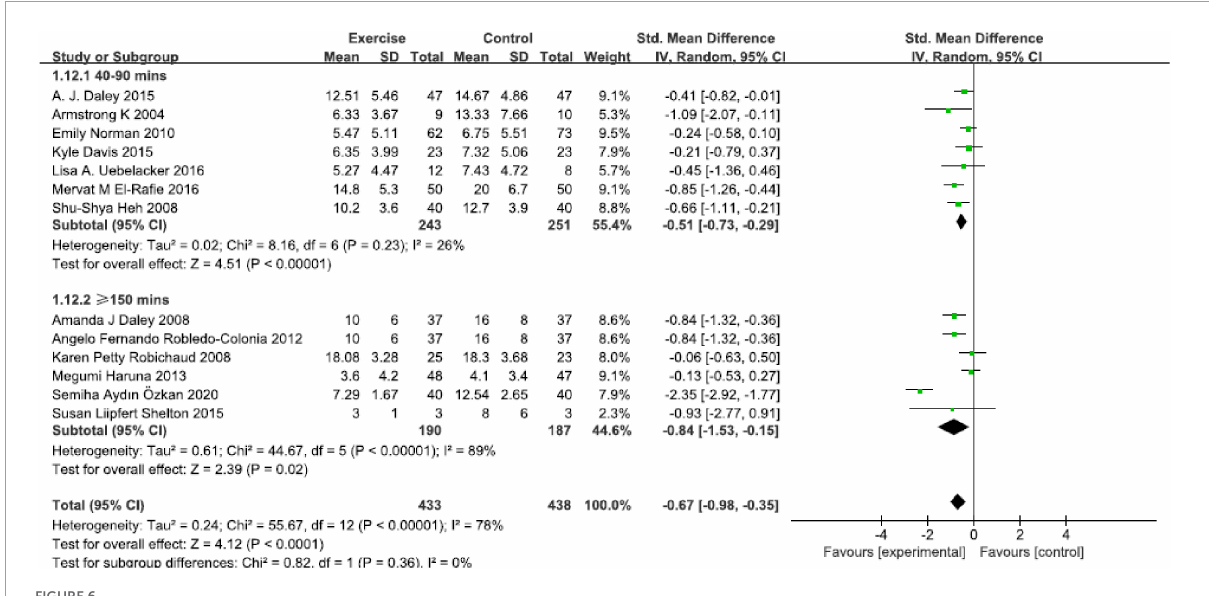
FIGURE6 Forest plot of the perinatal depression symptoms scores at different physical exercise intervention intensities.